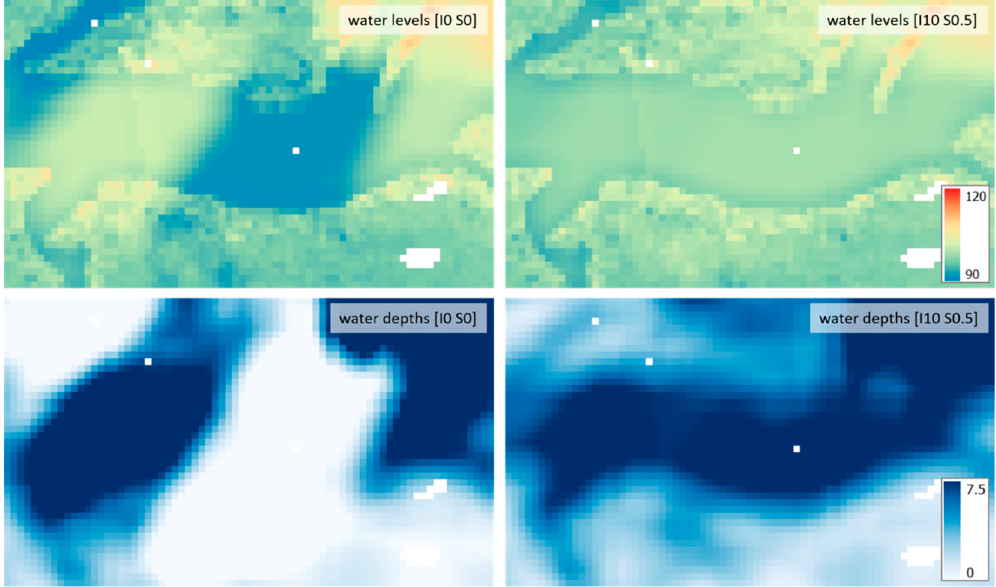
Figure 10. Results of FwDET using MERIT DEM and flood map derived from Sentinel-1 imagery of 16 July 2019, for the area highlighted in Figure 9. The effect of a ‘gap’ in the flood map, situated where the river is located within the DEM (and thus having a low elevation value) is clearly visible. The issue is largely removed in [I10 S0.5], with the river now having more continuous water depth values.